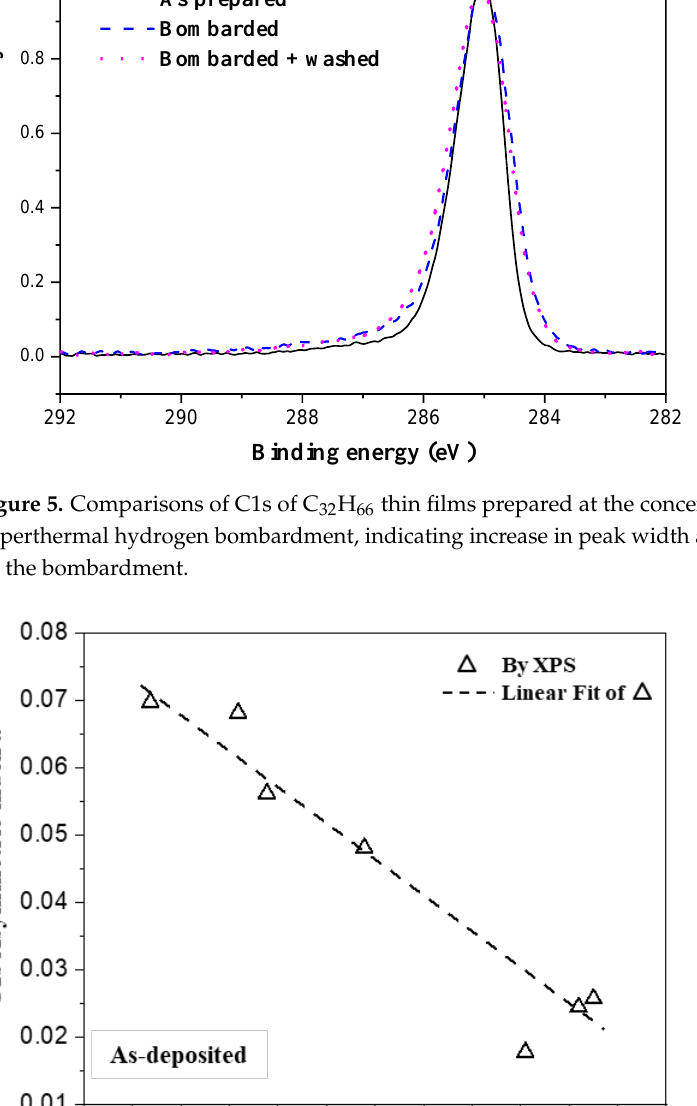
Figure 4. Thickness of C 32 H 66 thin films estimated from the XPS intensities as a function of its spin coating concentration.